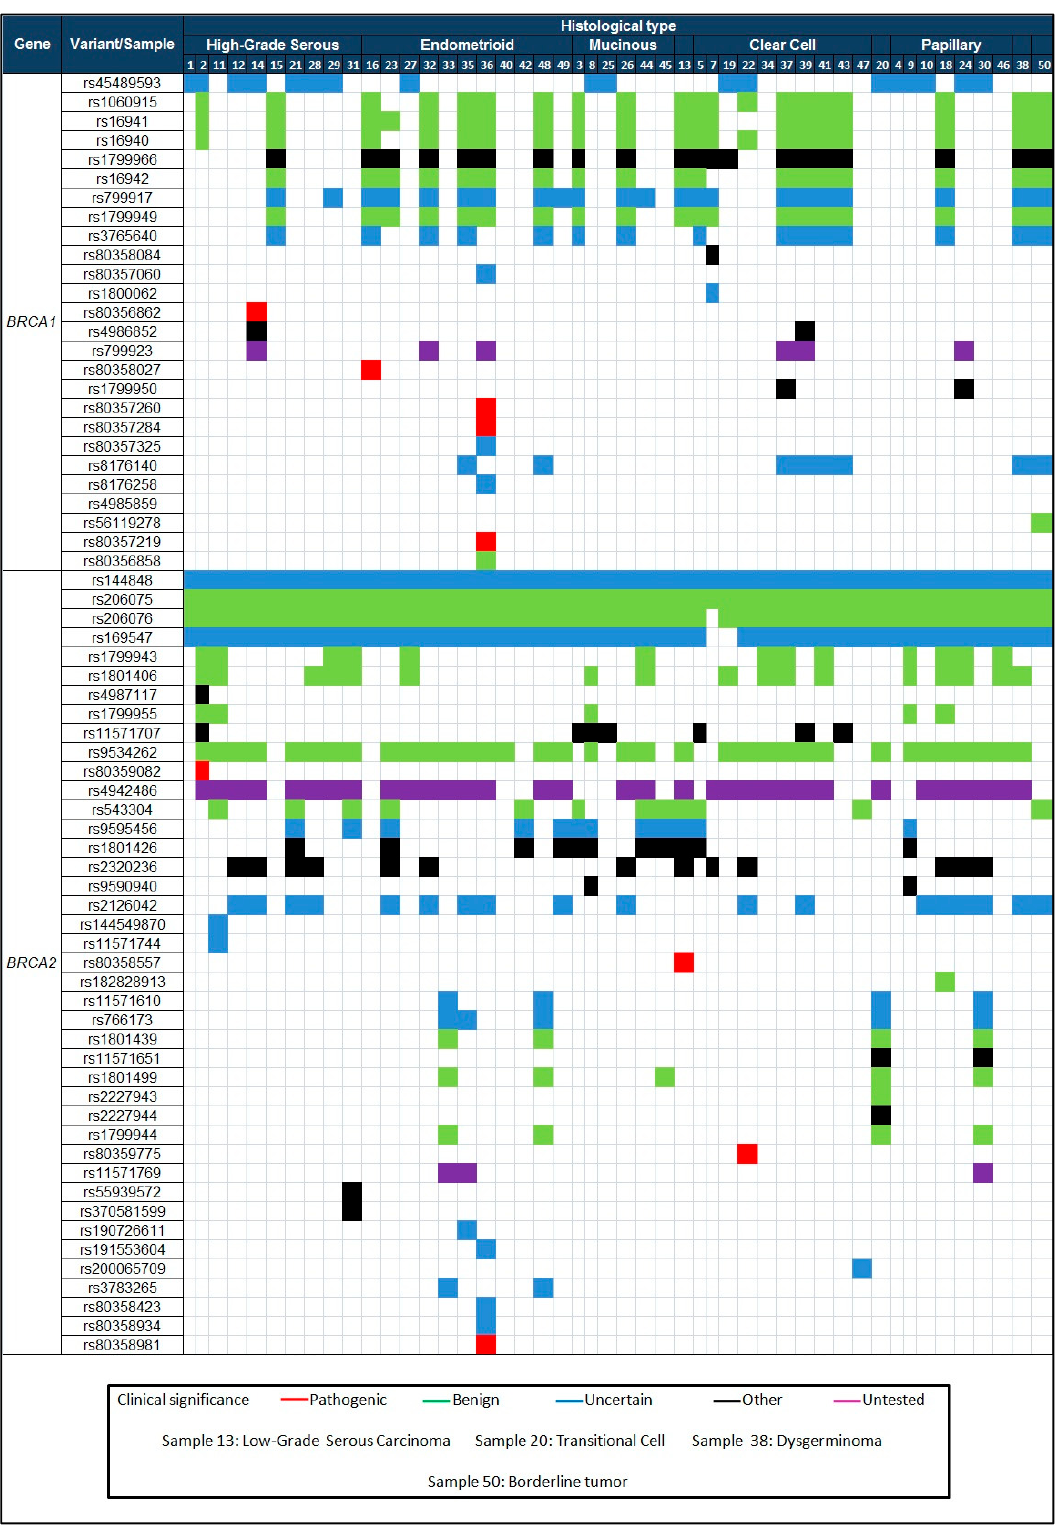
Figure 1. Variants reported for the BRCA1 and BRCA2 genes and their clinical significance by histological types.